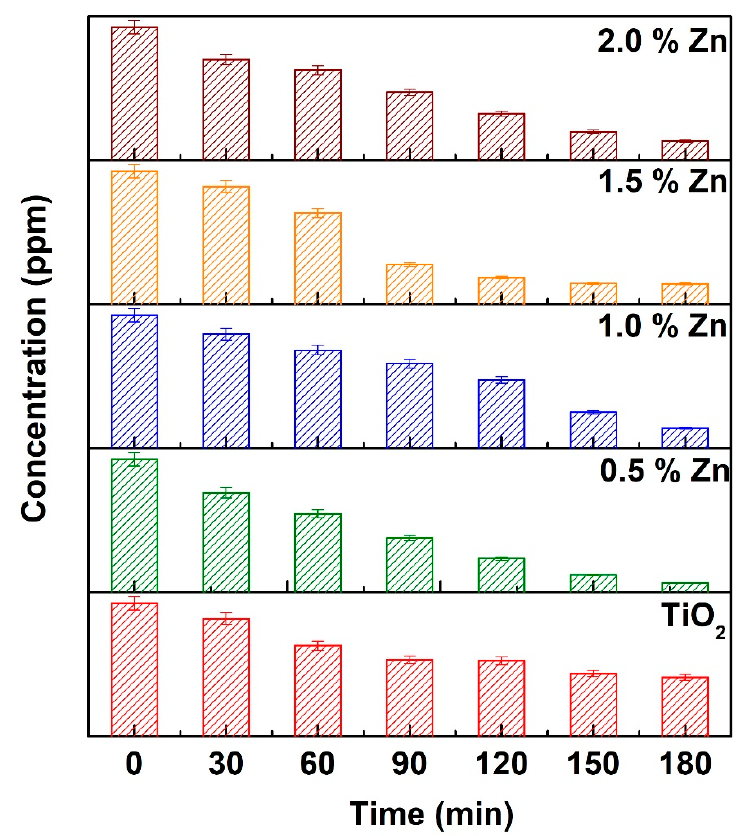
Figure 6. Concentration vs. time plot for degradation of methylene blue (MB) by undoped, 0.5, 1.0, 1.5, and 2.0 mol% Zn-doped TiO 2 as photocatalysts under direct sunlight. Table 3. Overall rate constants for photocatalytic degradation of MB under direct sunlight with undoped, 0.5, 1.0, 1.5, and 2.0 mol% Zn-doped TiO 2 as